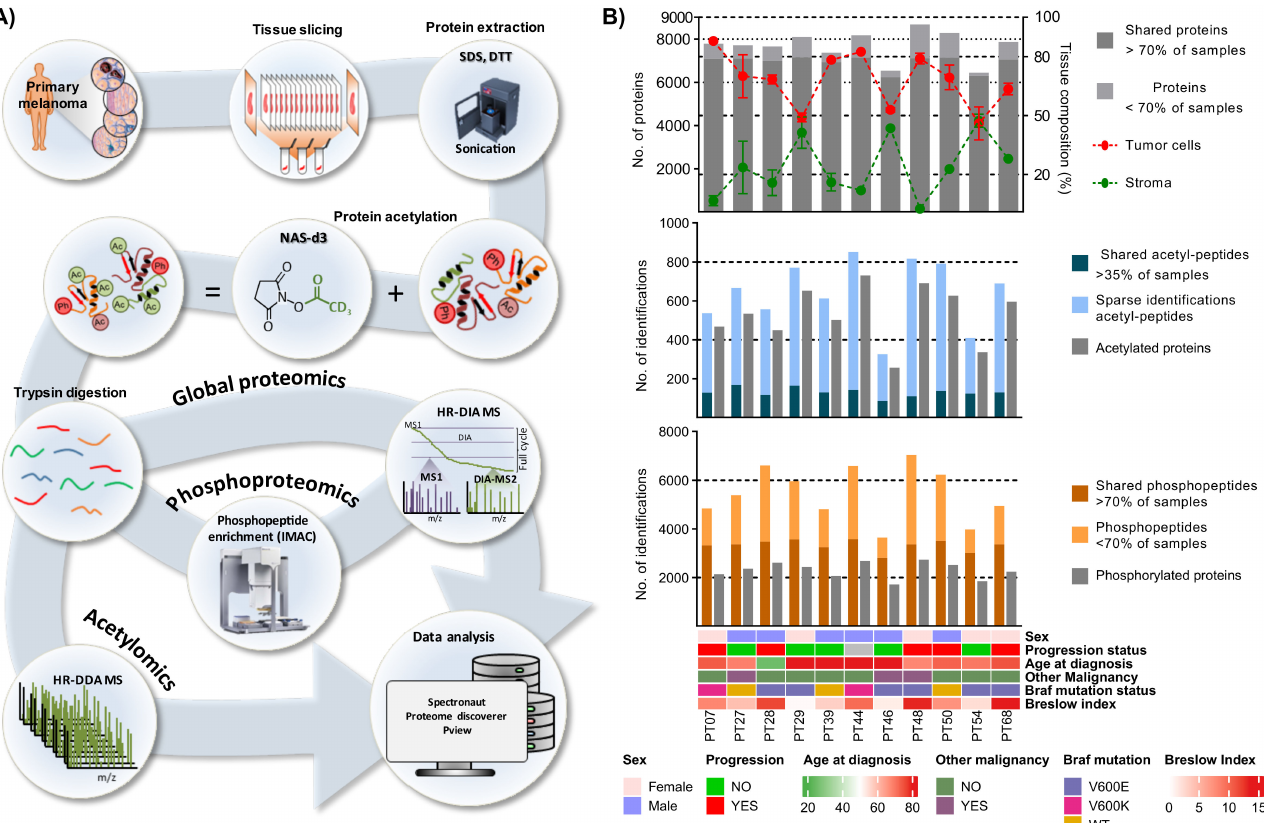
Figure 1. Multiomic analysis of primary melanomas. ( A ) Sample preparation workflow for global proteomics, phosphopro- teomics and acetylomics. ( B ) Distribution of proteins identified in the primary melanoma cohort and the tissue composition according to the histopathological characterization (% of tumor cells and stromal compartment) (top panel), distribution of the PTMs identified (acetylation and phosphorylation) (middle and bottom panels), and relevant clinical data of the patients and samples in the cohort